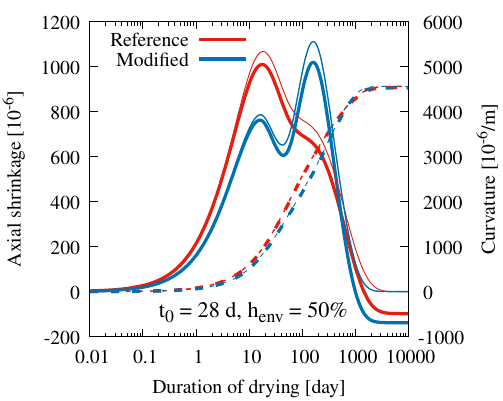
Figure 13. Evolution of axial shrinkage and cur- vature obtained with the “reference” and “modified” set of material parameters of the di ff usivity function (Fig. 12) and D = 150 mm, t 0 = 28 days, h env = 50%. Thin lines correspond to the behavior without vis- coelastic e ff